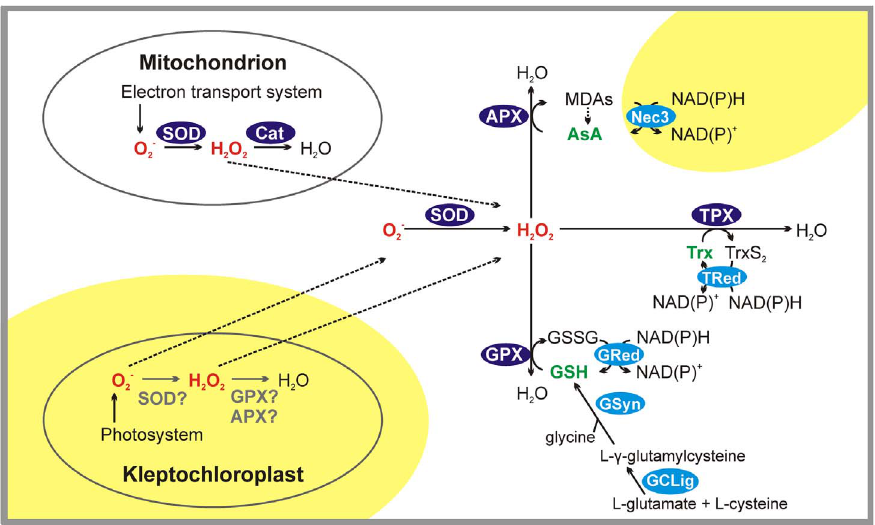
Figure 4. Hypothetical pathways for reactive oxygen species (ROS) detoxification. Pathways evidenced in both ciliates (white background) or only in Strombidium rassoulzadegani (yellow background) are shown. In red, ROS (O 2- = superoxide radical; H 2 O 2 = hydrogen peroxide); in dark blue, antioxidant enzymes (SOD = superoxide dismutase; Cat = catalase; APX = ascorbate peroxidase; GPX = glutathione peroxidase; TPX = thioredoxin peroxidase); in light blue, enzymes involved in metabolism of non-enzymatic antioxidants (Nec3 = bifunctional monodehydroascorbate reductase/carbonic anhydrase nectarin-3-like; TRed = thioredoxin reductase; GRed = glutathione reductase; GSyn = GSH synthetase; GCLig = Glutamate-cysteine ligase); in green, non-enzymatic antioxidants (AsA = ascorbic acid; GSH = glutathione; Trx = thioredoxin). MDAs = monodehydroascorbate; GSSG = glutathione disulfide; TrxS 2 = thioredoxin disulfide; NAD(P) + = nicotinamide adenine dinucleotide (phosphate). Based on literature